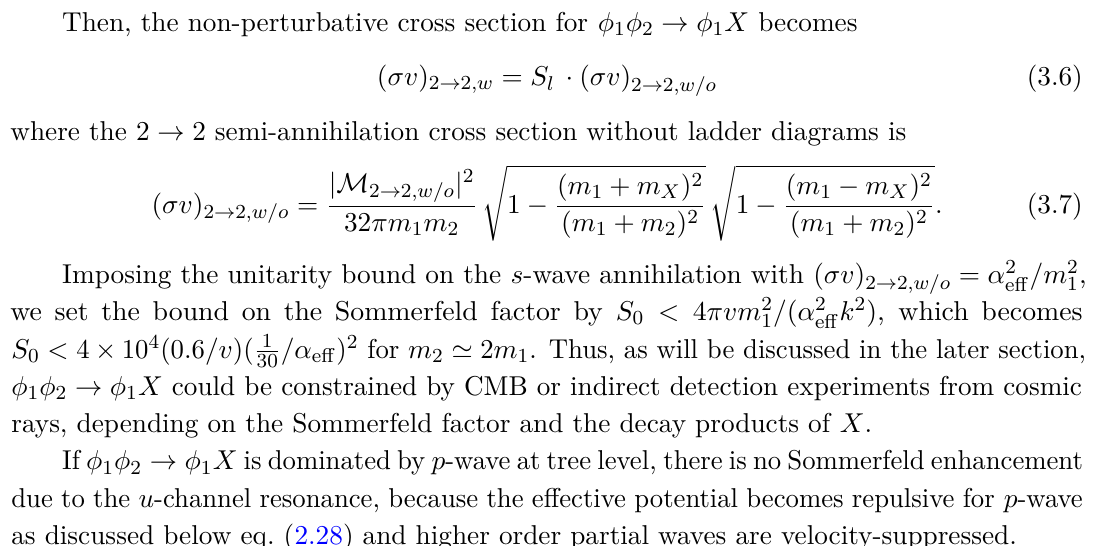
2 dark matter annihilation, φ 1 φ 1 φ ∗ 1 →